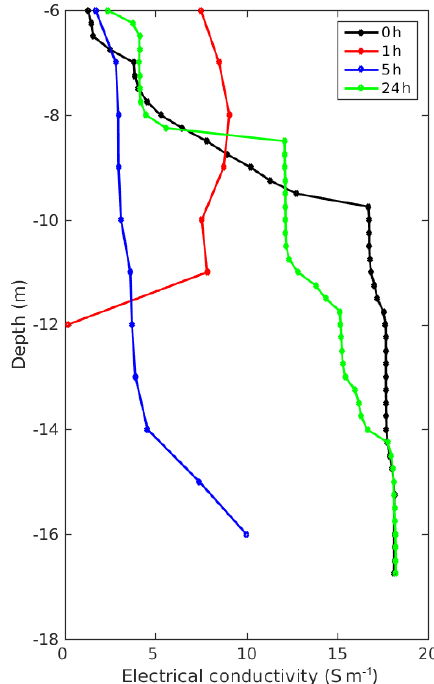
Figure 3. Electrical conductivity log of the fluid in borehole 5 at different times after start of freshwater injection (Sect. 2.2). 0h de- notes the background measurement before injection. At 1h there are no measurements below 12mb.g.s. because the packer system occupied the